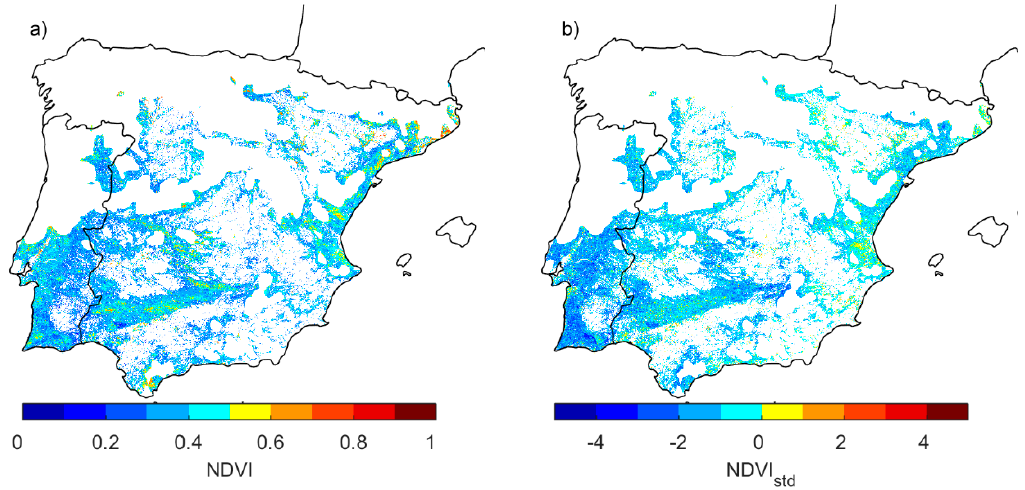
Figure 2. ( a ) Normalized Difference Vegetation Index (NDVI) observed in June 2005 and ( b ) NDVI std values in June 2005.